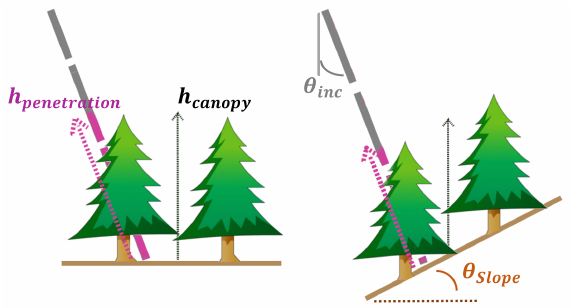
Figure 4. The influence of the Slope on the height inversion.